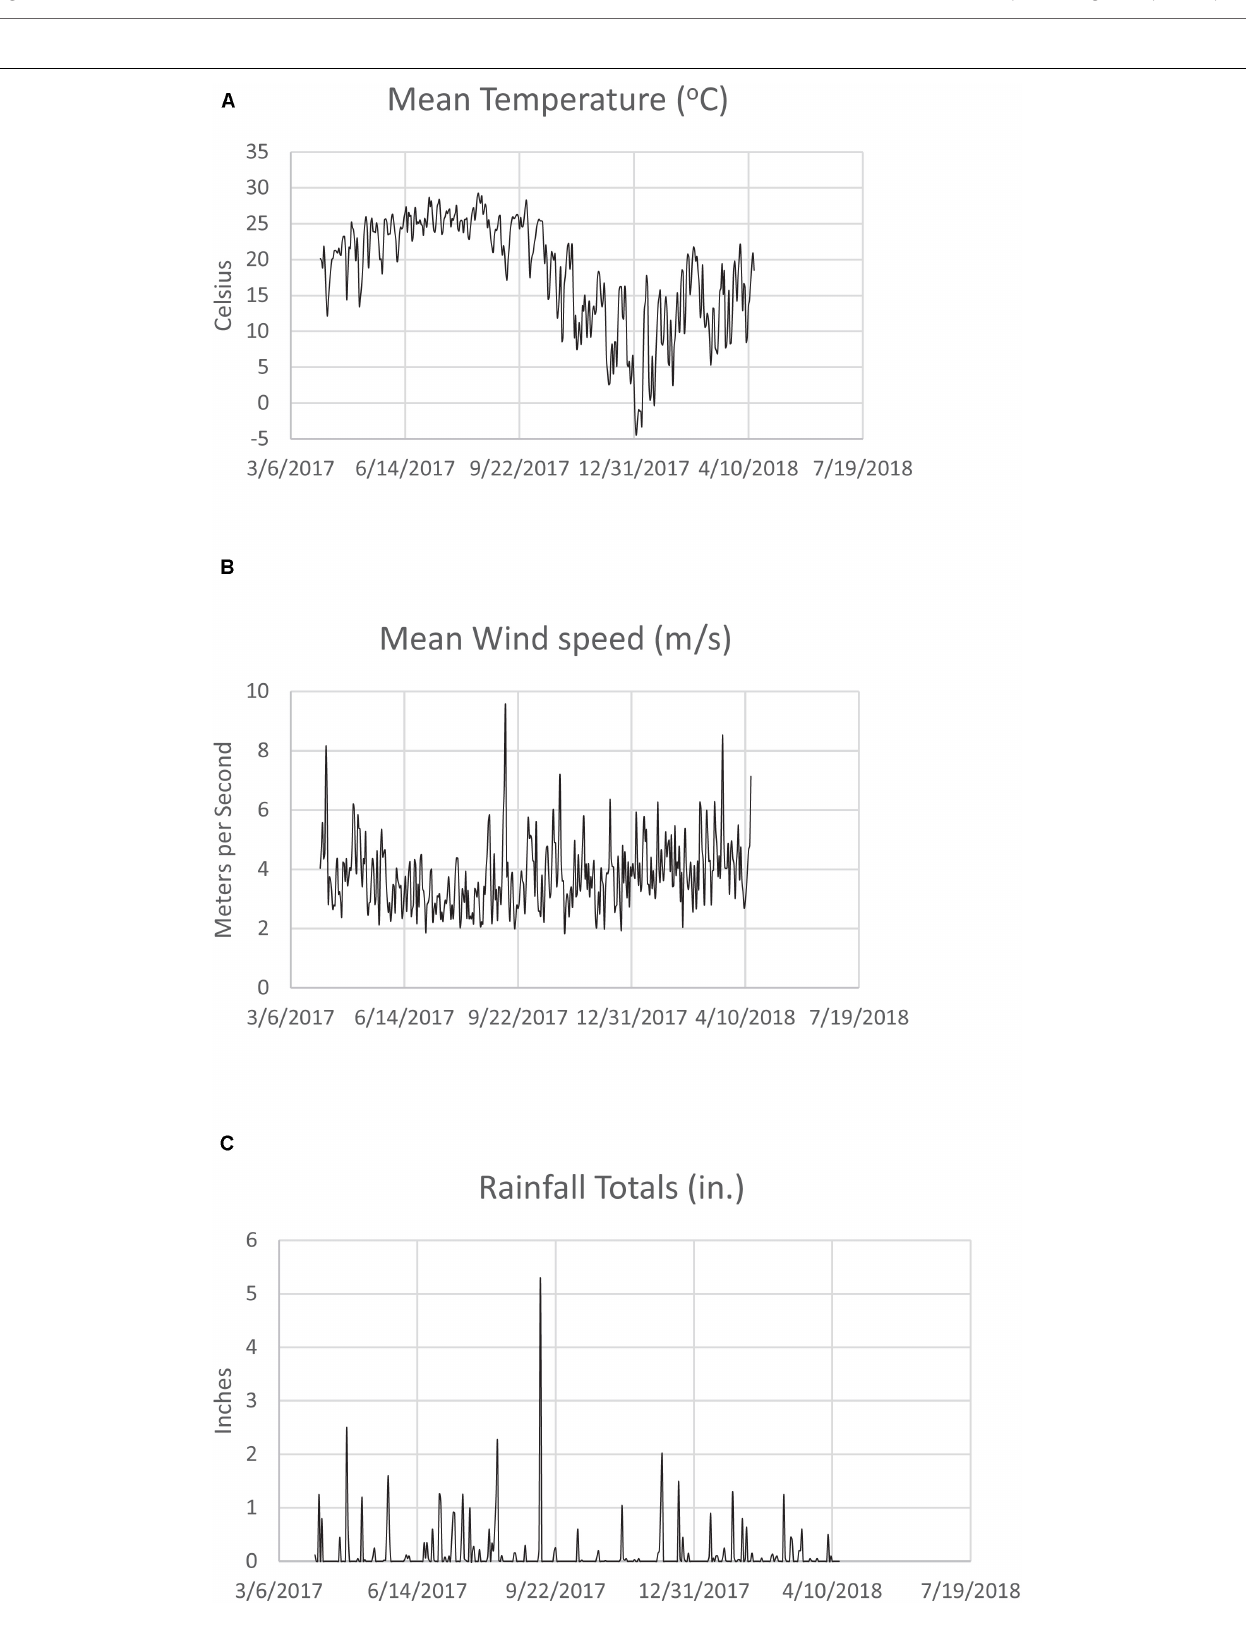
Frontiers in Microbiology |